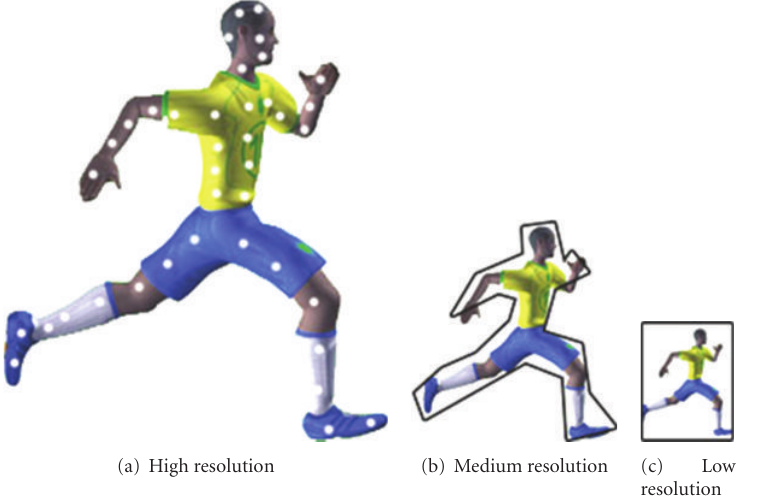
Figure 1: The three scenarios of surveillance system.